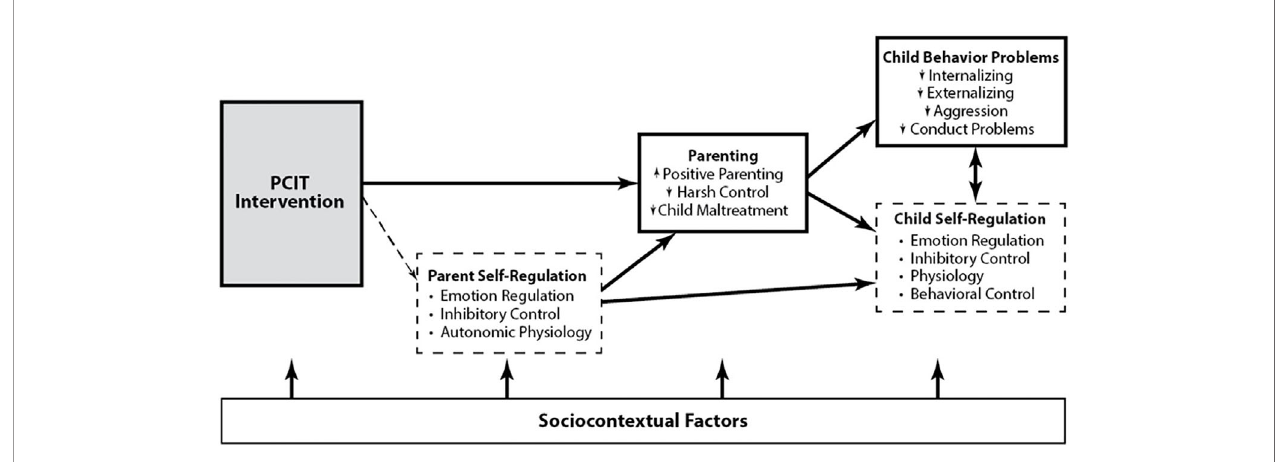
FIGURE 1 | Conceptual model of the study. Known (in bold) and hypothesized (in dashed) PCIT intervention effects on child maltreating (CM) parent and child